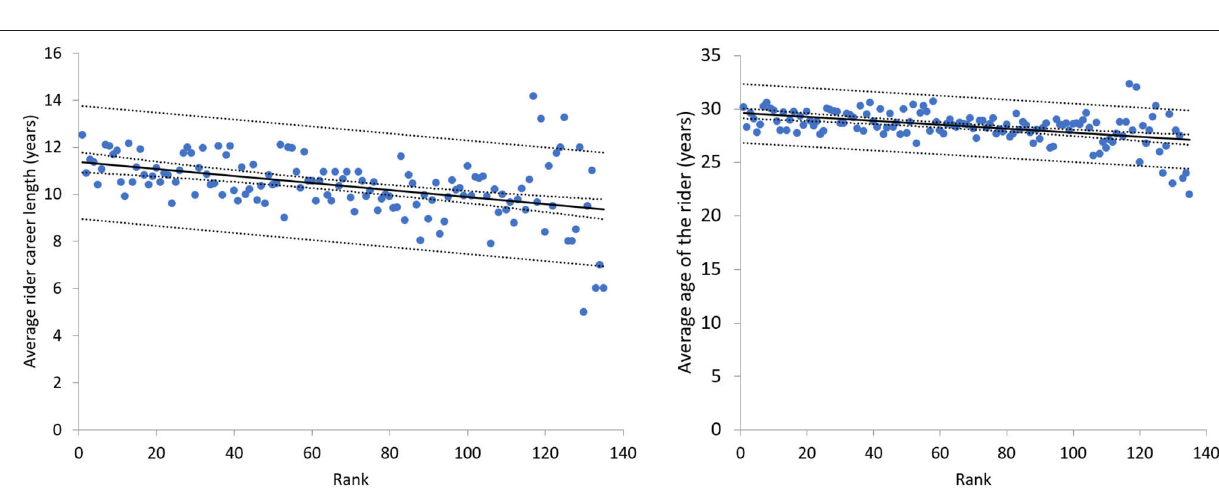
FIGURE 5 | The trend of average career length (left) and age (right) relative to the rank. Each point represents the rank and the career length/age of the riders of the Tour of Flanders from 2000 to